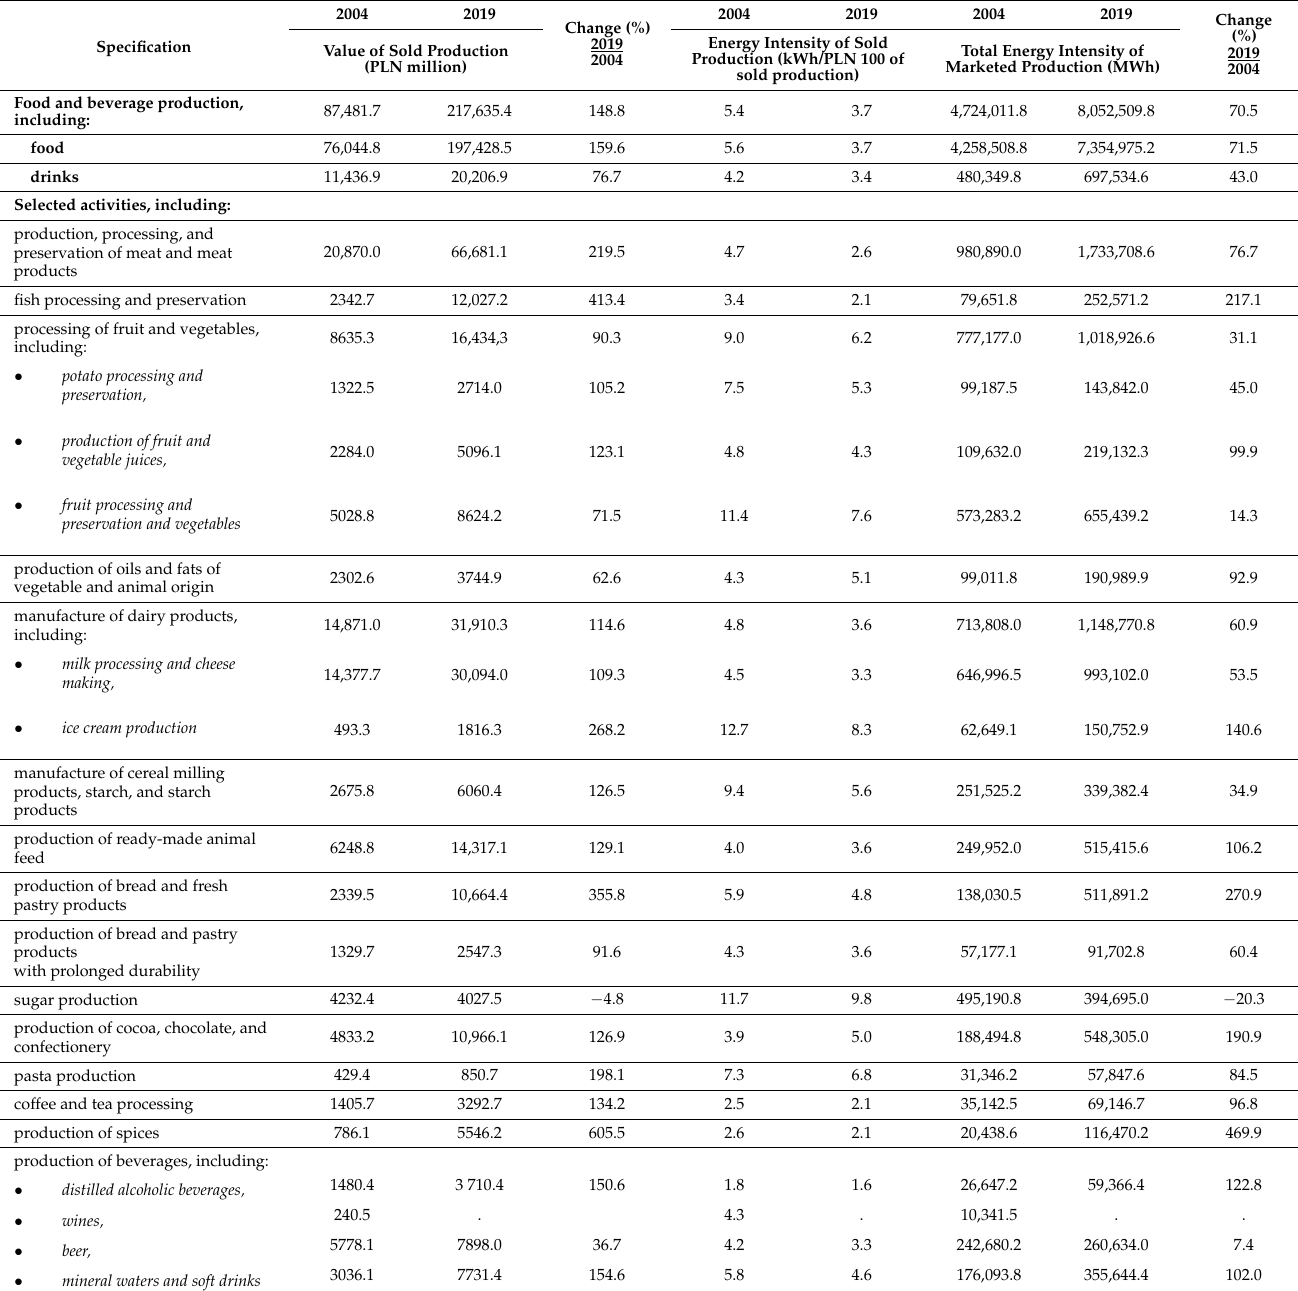
Table 5. Sold production of the food industry a and energy intensity of production b (in medium and large